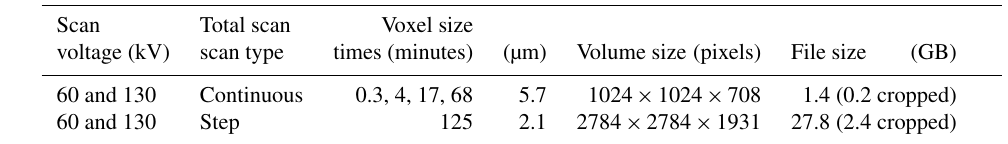
Figure 1. (a) Transmitted light micrograph of a sample mount with known apatite and zircon standard shards and unknown sample grains made from a plastic slide and double-sided tape, about 3mm in width. (b) Sample mount installed vertically in the microCT instrument secured on top of a sample holder with dental wax. Insert shows a closer view of the sample mount in measurement position. (c) X-ray projection of the same mount as in (a) . Zircon grains show up as darker (more X-ray absorption) than apatite grains. The brightness in projections is controlled by the material-specific X-ray attenuation as well as by the integrated thickness of the traversed material. Table 2. Scan parameters tested in this